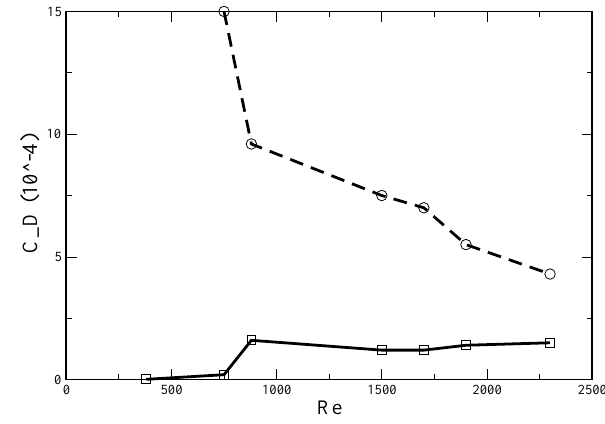
Fig. 2. The drag coefficient c D (straight line) and the effective Fig. 12. The drag coefficient c D (straight line) and the effective drag coefficient ˜ c D (dashed line), are presented as a function of drag coefficient ˜ c D (dashed line), are presented as a function of the Reynolds number (based on the laminar Ekman layer thickness) the Reynolds number (based on the laminar Ekman layer thickness) Re Ek Re Ek .